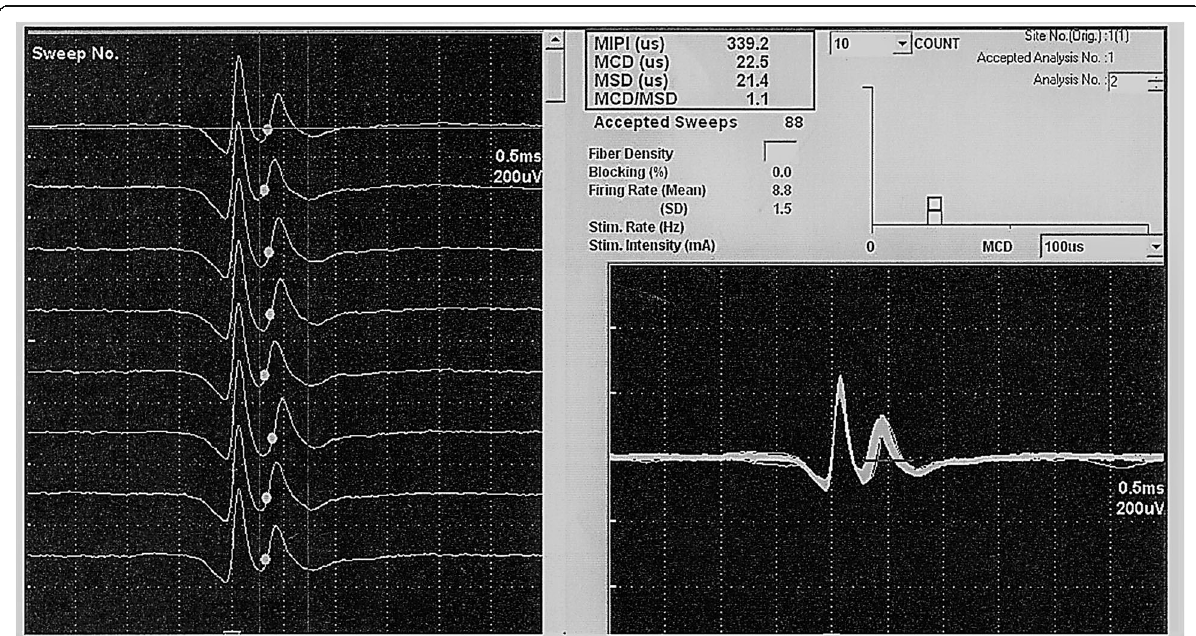
Fig. 1 SFEMG potentials recorded from APB during voluntary contraction. Trace obtained from a control subject. MCD is 22.5 μ s